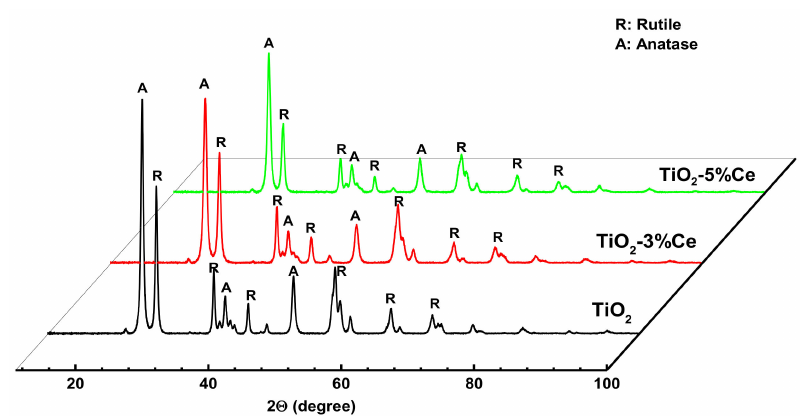
Figure 6. XRD patterns of the fibrous TiO 2 and TiO 2 –x% Ce samples.